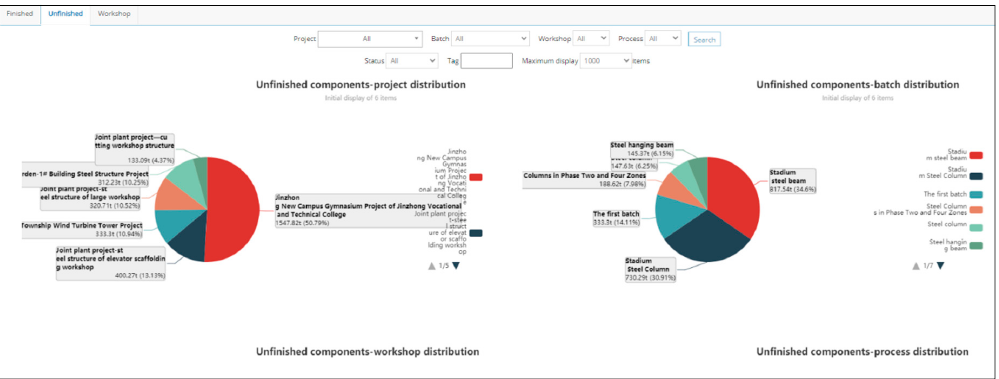
Figure 11. Progress management ( a ) 4D model of the Jinjian Yingxi Garden-1# Building Steel Structure Project; ( b ) 4D model of another project.